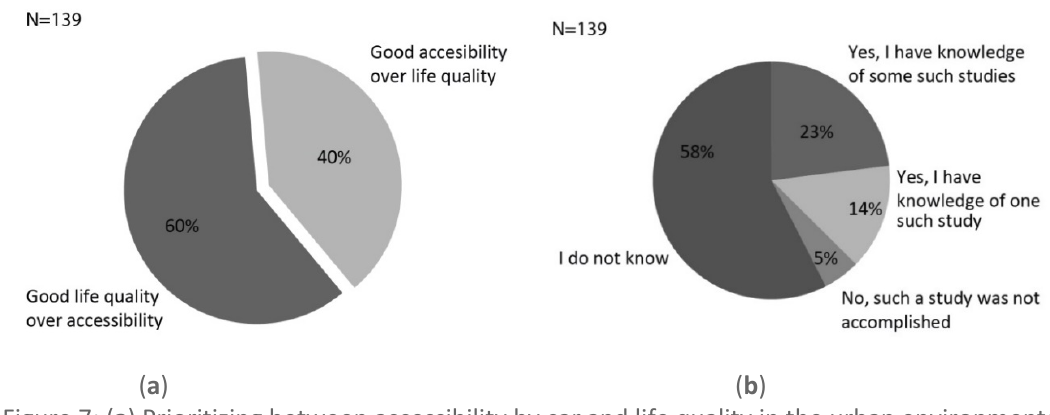
Figure 7: ( a ) Prioritizing between accessibility by car and life quality in the urban environment;